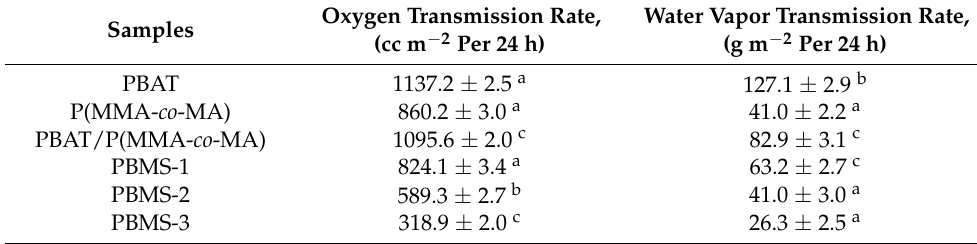
Table 3. Barrier properties of PBAT/P(MMA- co -MA)–SiO 2 composite films.